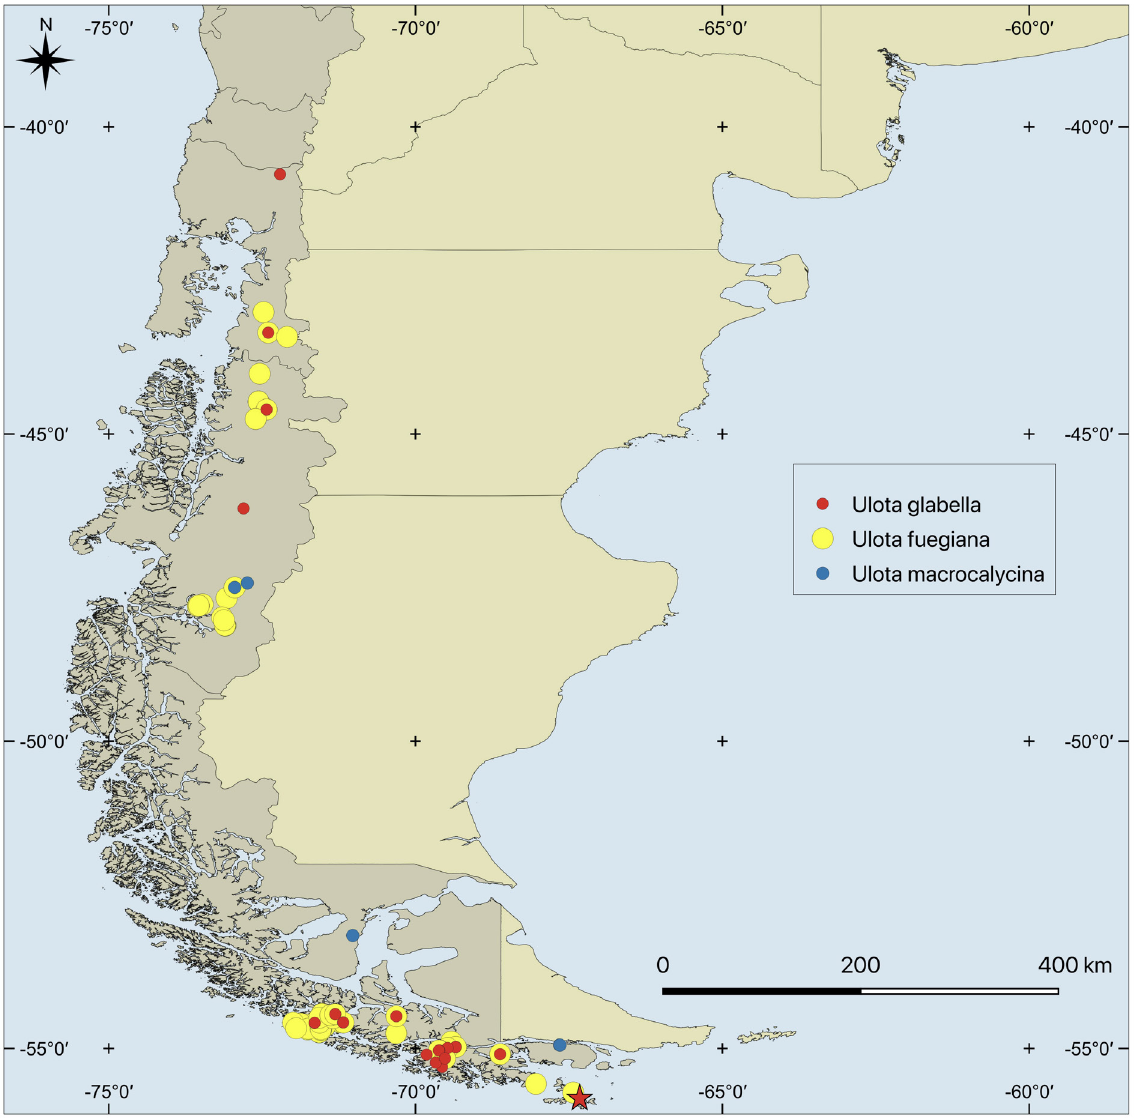
Fig . 2 . Origin of the studied specimens. The locus classicus of Ulota glabella Mitt. is marked with a